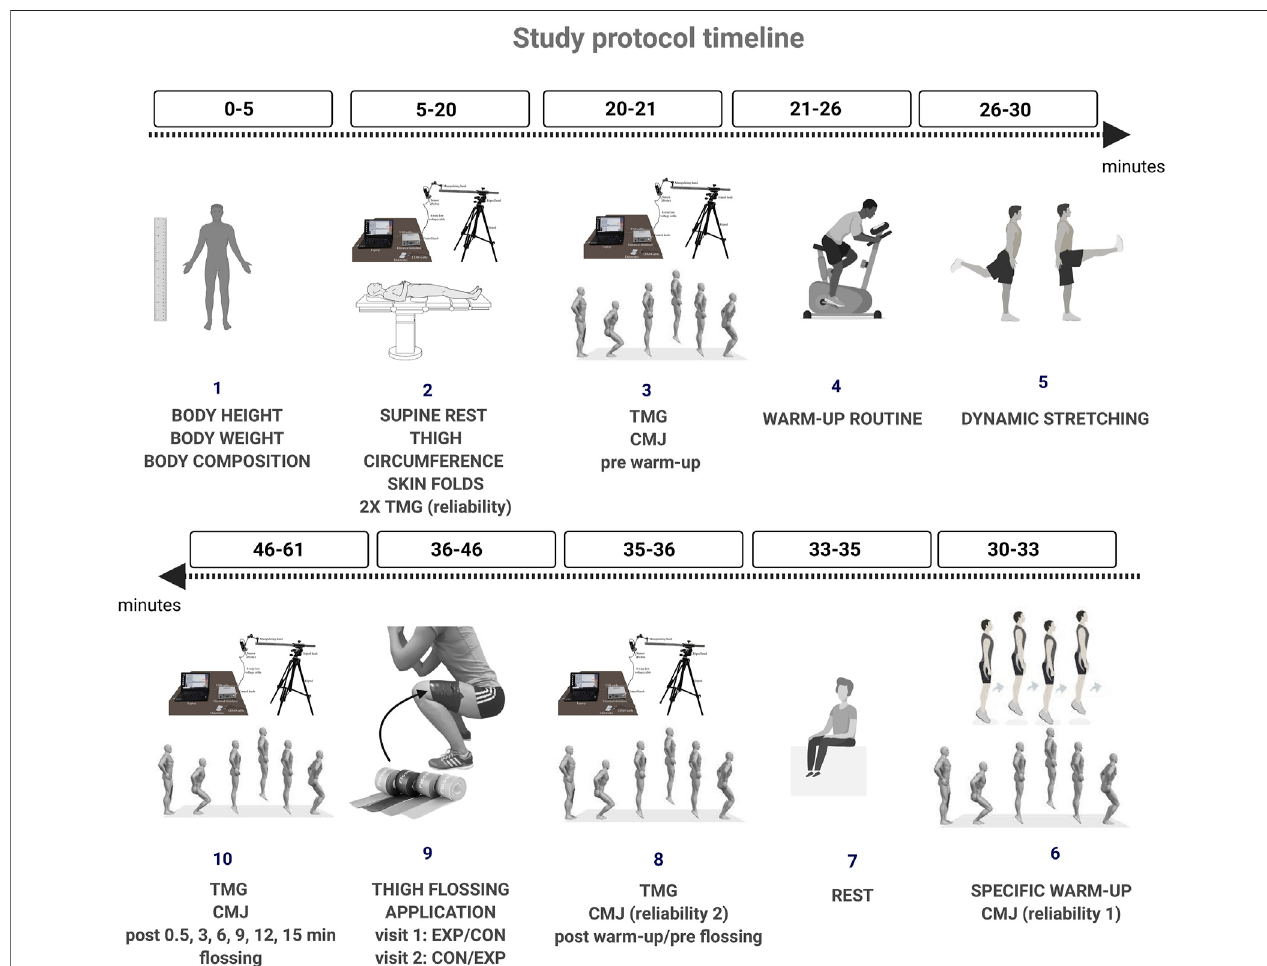
FIGURE 1 | The schematic diagram of the research